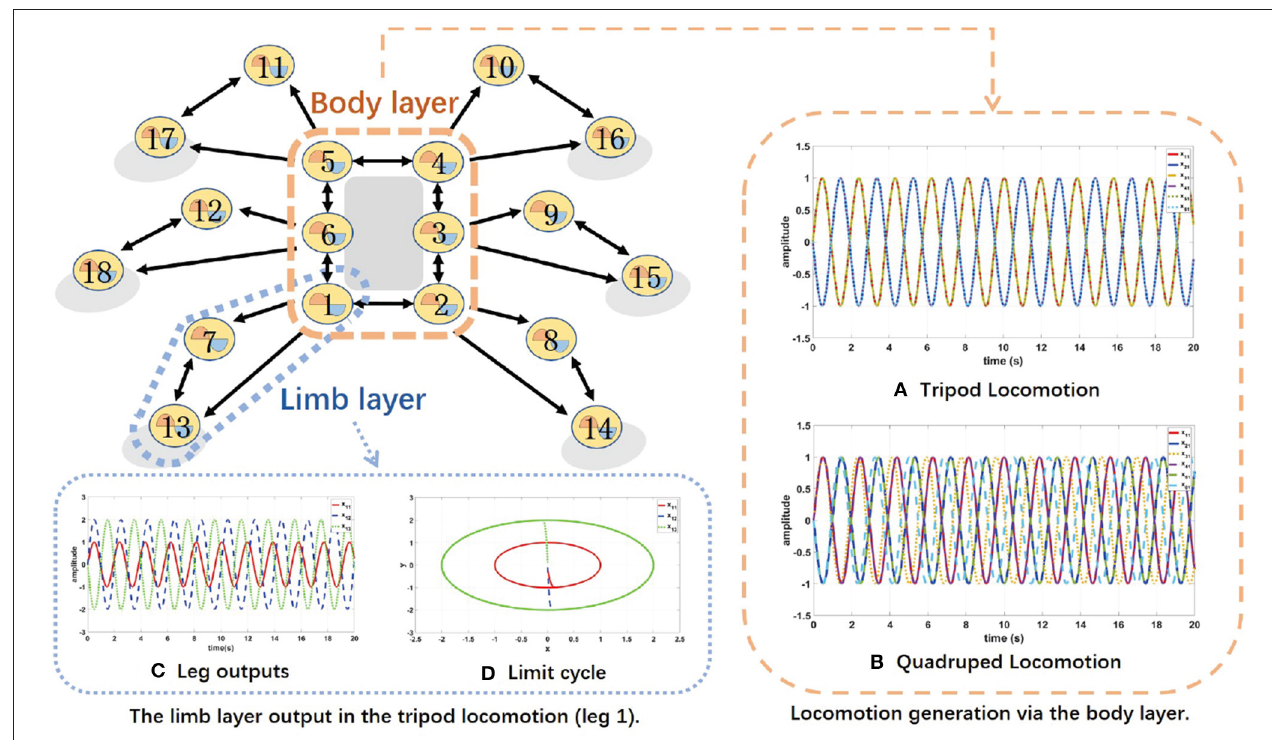
FIGURE 5 | The topology network of the proposed two-layer